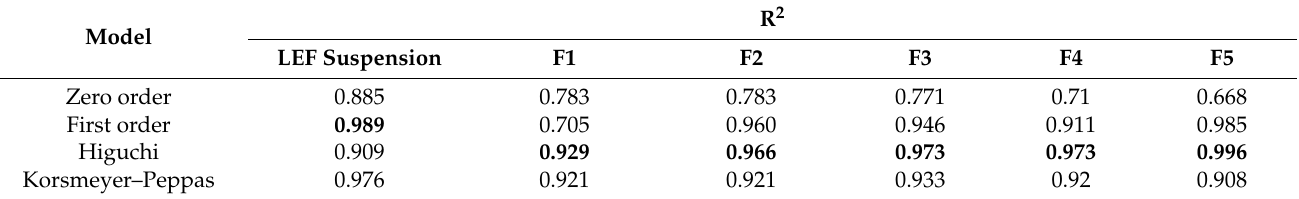
Table 3. Release